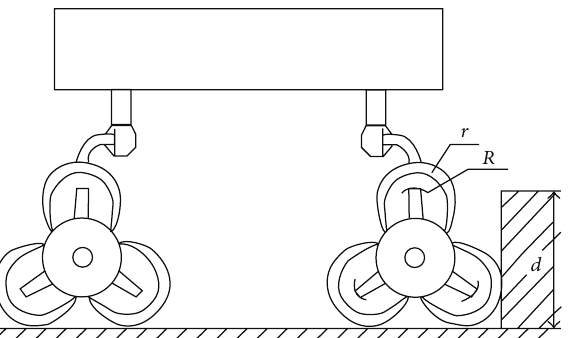
Figure 4: The planetary wheeled mobile